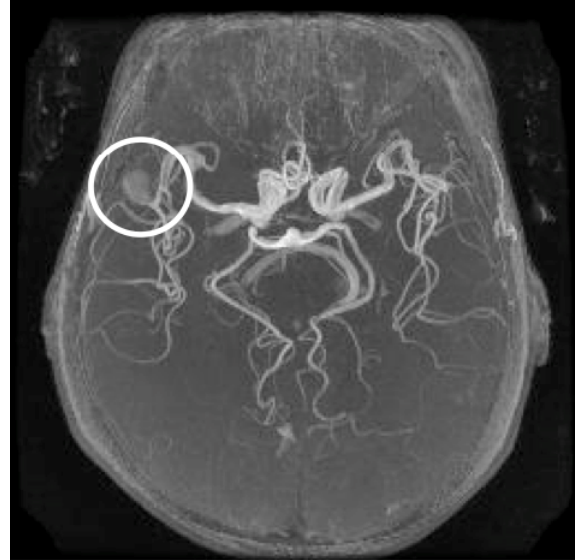
Figure 1. An illustration of the output by a CAD system for detection of intracranial aneurysms in MRA images